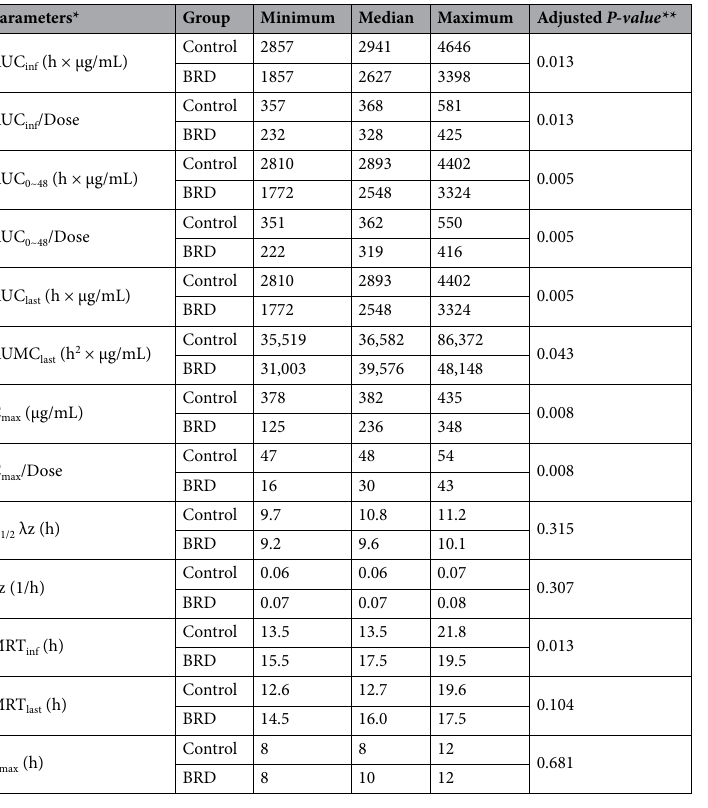
Table 4. The fecal pharmacokinetic parameters of danofloxacin administered to calves subcutaneously (8 mg/ kg body weight) computed by a non-compartmental model (i.e., statistical moments) analysis. * PK-parameters area under the curve from the time of dosing extrapolated to infinity (AUC inf ), area under the curve from the time of dosing to the last sampling time point (AUC 0~48 ), area under the curve from the time of dosing to the last measurable positive concentration (AUC last ), area under the first moment curve from dosing to the last measurable concentration (AUMC last ), maximum observed concentration (C max ), mean residence time from the time of dosing to the last measurable concentration (MRT last ), time to the maximum concentration (T max ), terminal half-life (T 1/2 λz), and elimination rate (λz). Groups control—healthy control calves, and BRD— M. haemolytica infected calves. **Mann–Whitney test was used to compare the control and BRD